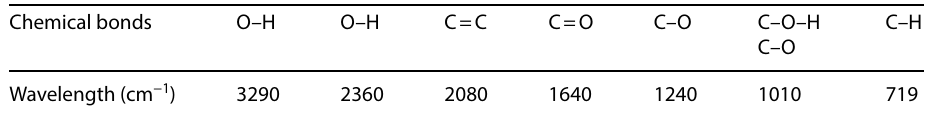
Table 7 Chemical bonds in different wavelength for synthesized monometallic gold and silver NPs and Au/ Ag